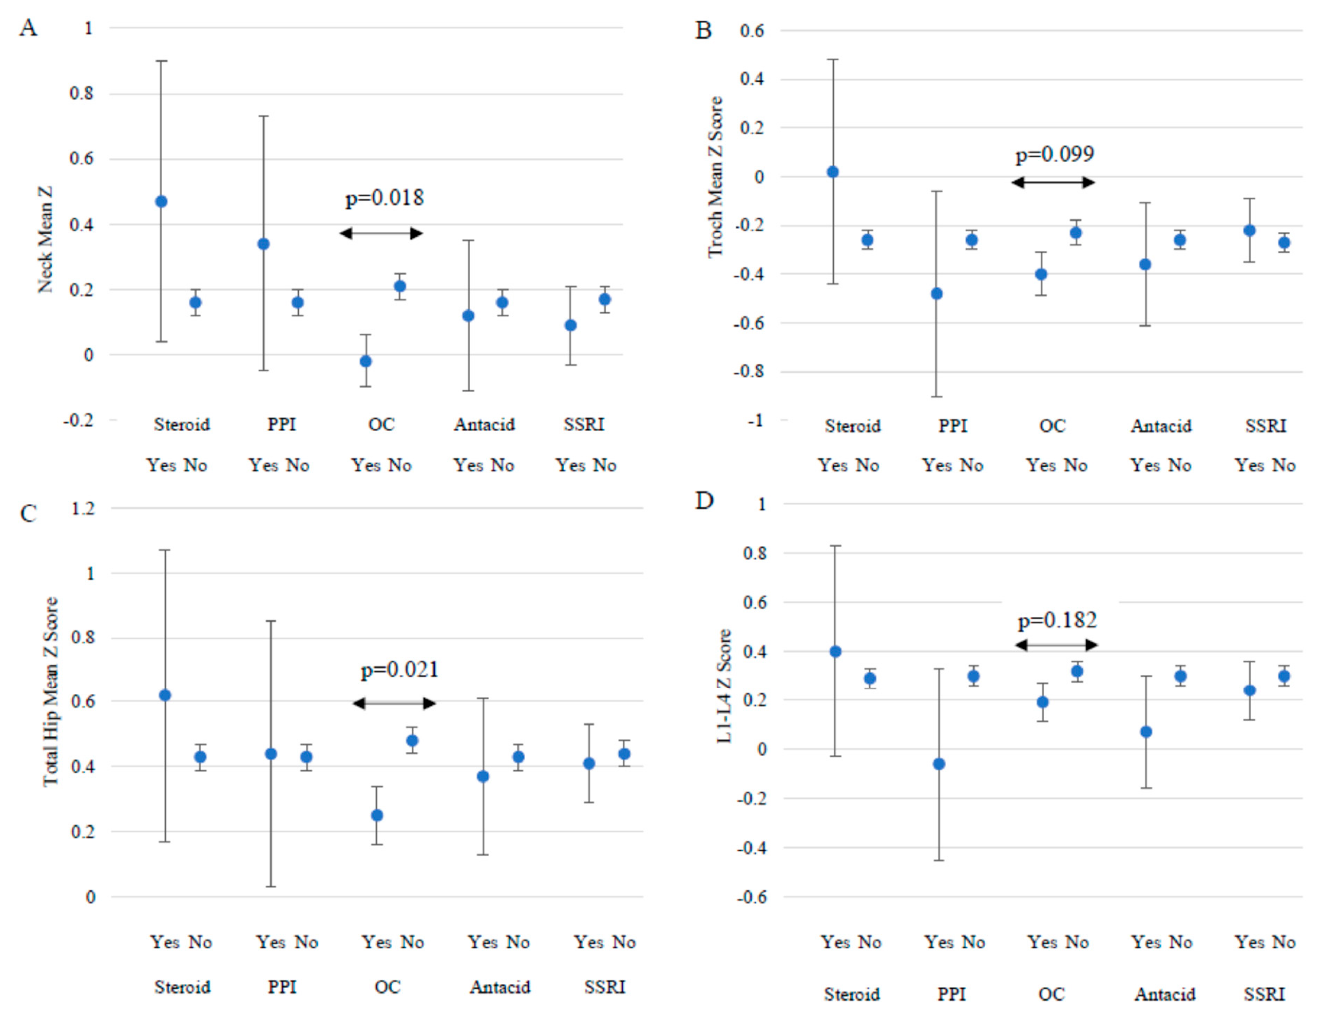
Figure 2. Lifetime medication usage and mean ± standard error BMD Z-score at each measurement site. ( A – D ), PPI = proton pump inhibitors. OC = oral contraceptives. SSRI = selective serotonin reuptake inhibitors. Steroids/prednisone yes ( n = 5), no ( n = 626); Proton pump inhibitors yes ( n = 6), no ( n = 625); Oral contraceptives yes ( n = 128), no ( n = 503); Antacids/aluminum yes ( n = 17), no ( n = 614); Selective serotonin reuptake inhibitors yes ( n = 65), no ( n = 566).